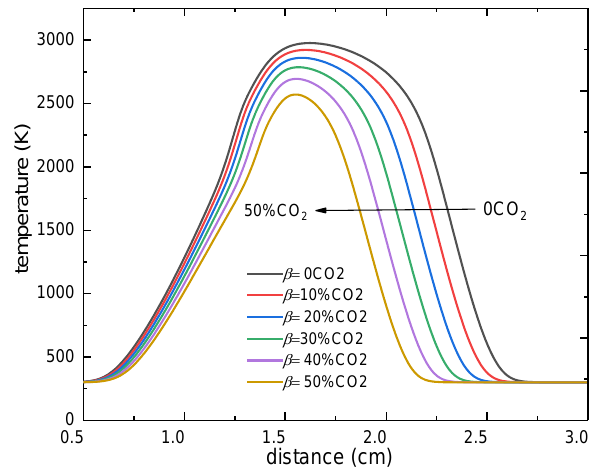
Figure 2. The effect of the CO 2 dilution ratio at p = 1 atm, 𝛼 𝑠 = 10 s −1 . To distinguish the chemical effect, the thermal effect, and the transport effect of CO 2 on the flame temperature, FCO 2 , TCO 2 , and XCO 2 were introduced to identify the discrepancies. Figure 3 qualitatively depicts the flame temperature distribution of the counterflow diffusion flame diluted by the ordinary CO 2 and the three specific artificial CO 2 . To enlarge the difference between the flame with and without CO 2 dilution, the maximum dilution ratio β = 50% was selected to demonstrate the effects. As seen in Figure 2, the influence of different dilution ratios on flame temperature distribution is only reflected in the size of the temperature drop. From Figure 3, the effects including the chemical effect, thermal effect, and transport effect were mainly presented in the downstream of the flame front (in the oxidizer side), and all three effects reduced the flame temperature. It is worth noting that the chemical effect and the thermal effect not only narrowed the reaction zone, shifting the position of the flame front, but also decreased the maximum flame temperature significantly. However, the transport effect (compare FCO 2 and XCO 2 ) of CO 2 only showed a weak influence on the flame temperature near the oxidizer, and no obvious change occurred on the maximum flame temperature. In the following analysis, the maximum flame temperature is the target parameter. The transport effect is too small to be ignored.